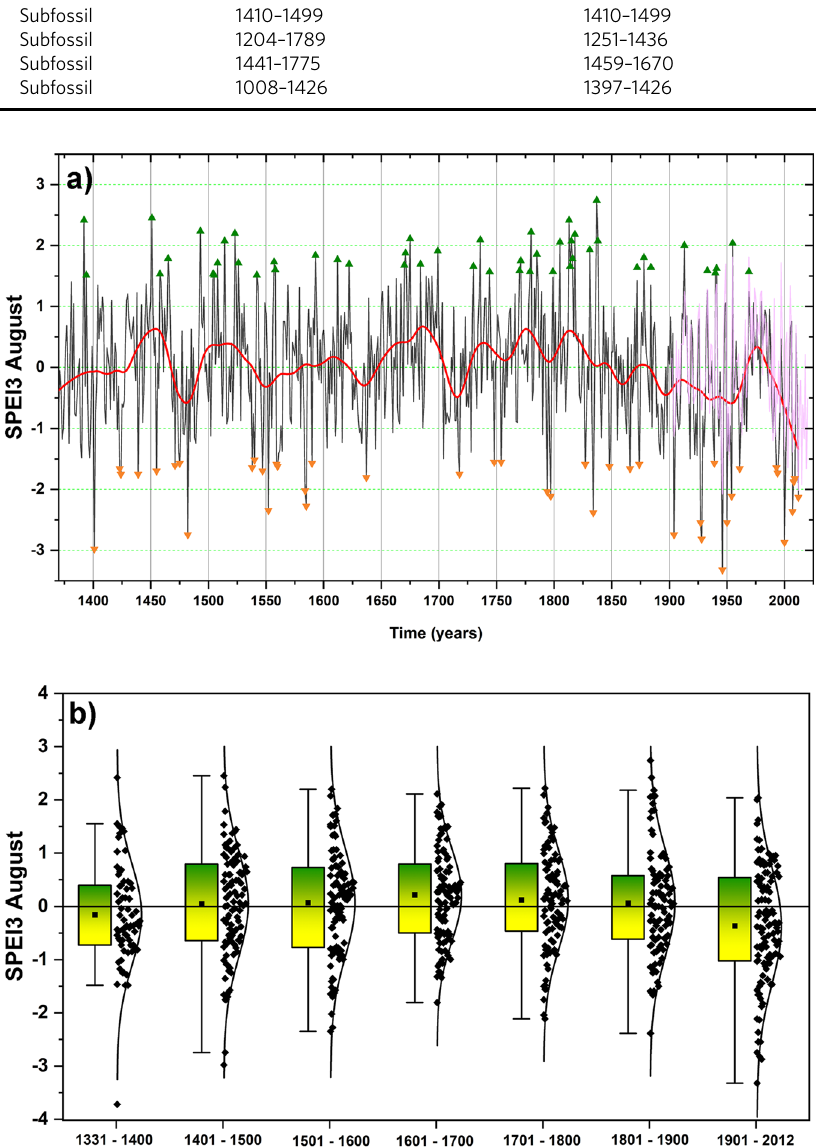
Fig. 4 Drought index reconstruction. a Reconstructed August SPEI3 (black line) for 1331 – 2012CE period, with the 31-year running mean (red line) and measured August SPEI3 for 1902 – 2012CE period (magenta line). Extreme dry/wet years are represented as lower-orange/upper-green triangles. Extreme years are de fi ned when the SPEI3 index is lower than − 1.5 or higher than + 1.5 standard deviation. b Box plots of the reconstructed August SPEI3 for different centuries over the period 1331 (1301) –